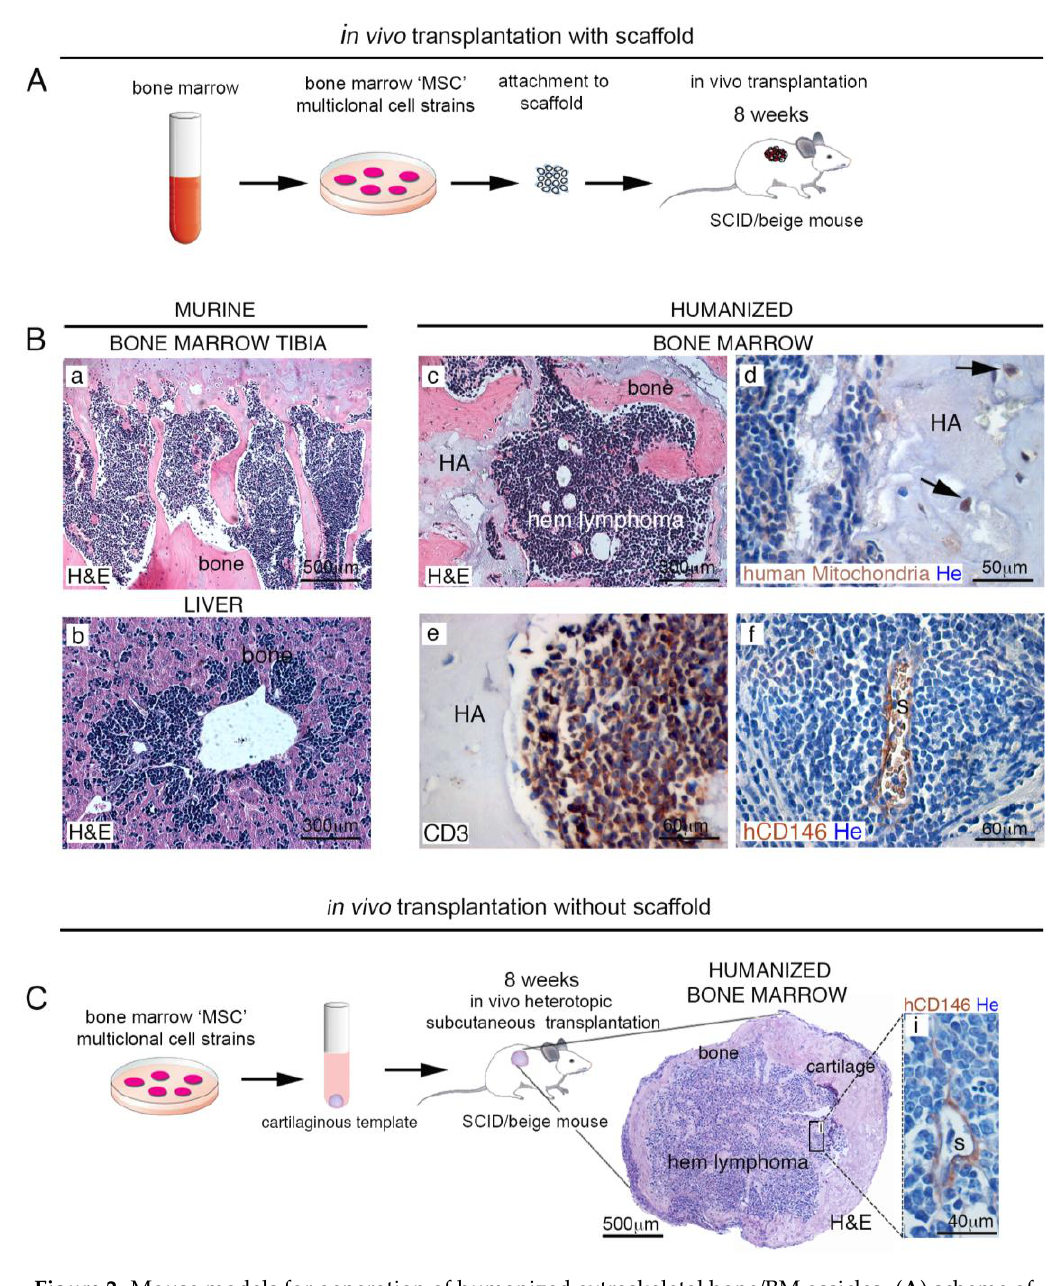
Figure 2. Mouse models for generation of humanized extraskeletal bone / BM ossicles. ( A ) scheme of in vivo transplantation protocol with sca ff old. In this model, ectopic bone / BM organ is generated by hBMSCs expanded in vitro, loaded onto osteoconductive carriers (e.g., using hydroxyapatite / tricalcium phosphate (HA / TCP)) and then transplanted in immunocompromised mice. About eight weeks post-transplantation, hBMSCs form a BM microenvironment. ( B ) In the experimental time-frame, a small number of SCID mice (~15%) developed spontaneous lymphomas. (a,b). Human hematopoietic supporting stromal cells in humanized bone / BM ossicles create a suitable environment for murine lymphomas metastases (c–f); ( C ) scheme of in vivo transplantation protocol without sca ff old. In this model, cells are grown in culture as unmineralized pellets in chondrogenic di ff erentiation medium and then transplanted into subcutaneous tissues of immunocompromised SCID / beige mice to generate heterotopic skeletal tissues. Eight weeks post-transplantation, hBMSCs develop a BM murine hematopoietic lymphoma-microenvironment. H&E, Hematoxylin / Eosin. HA, hydroxyapatite; hem, hematopoiesis; s, sinusoid. He, Hematoxylin counterstaining. All data shown are representative results derived from one of at least three independent experiments. Scale bars represent 40, 50, 60, 300, 500 µ m as